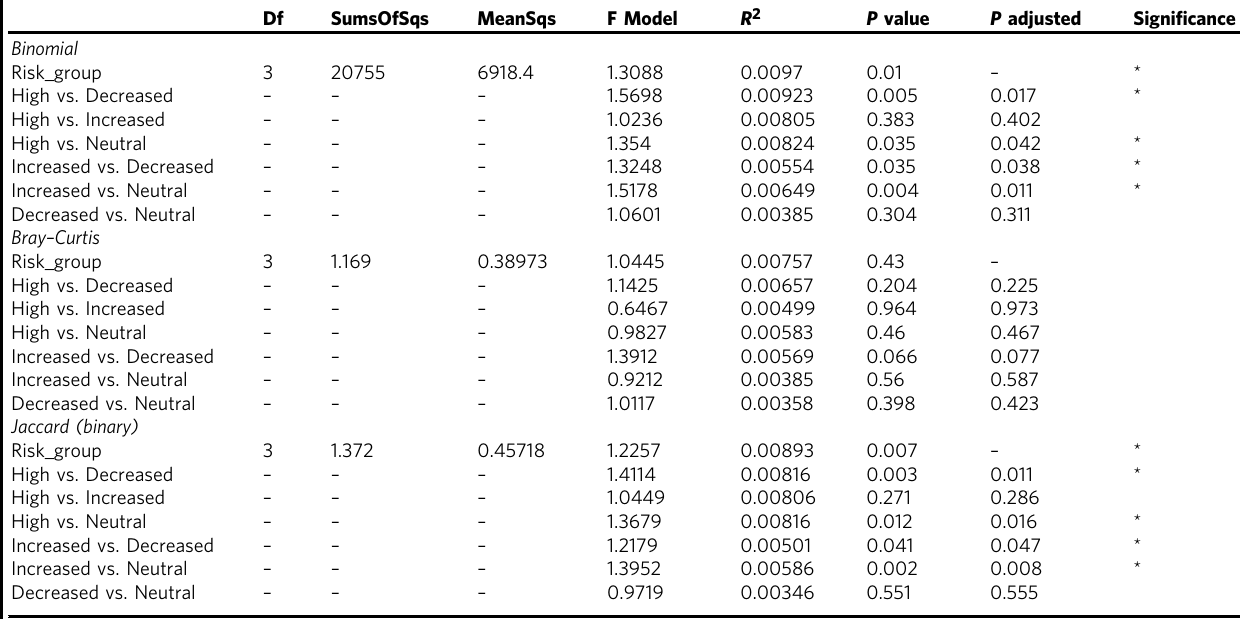
Table 1 Risk groups that are signi fi cantly different by